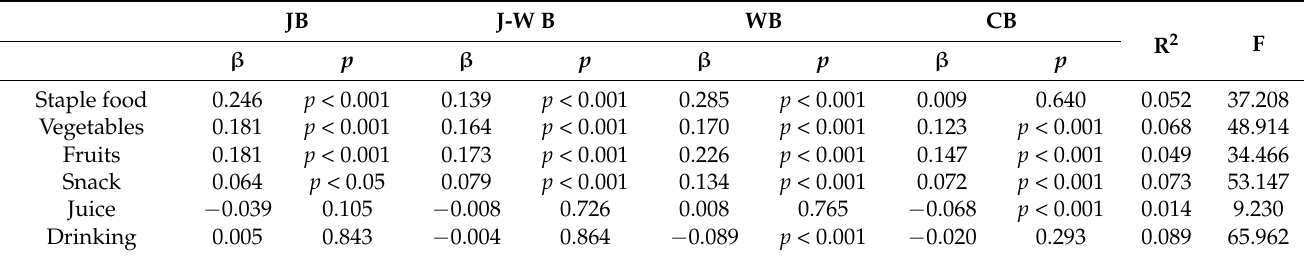
Table 2. Results of the multiple regression analysis of the relationship between breakfast style and food intake.